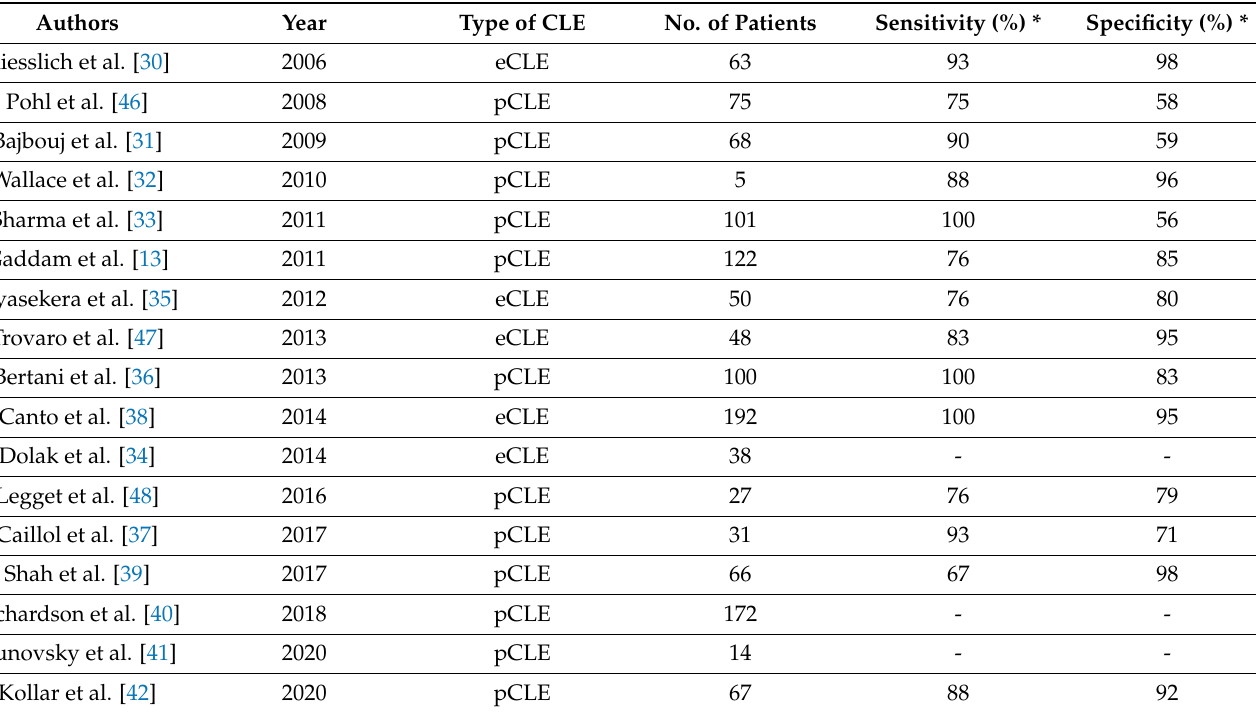
Table 2. Summary of CLE studies in BE and EAC diagnostics (table created according to Vranic et al. [28] and Xiong et al.